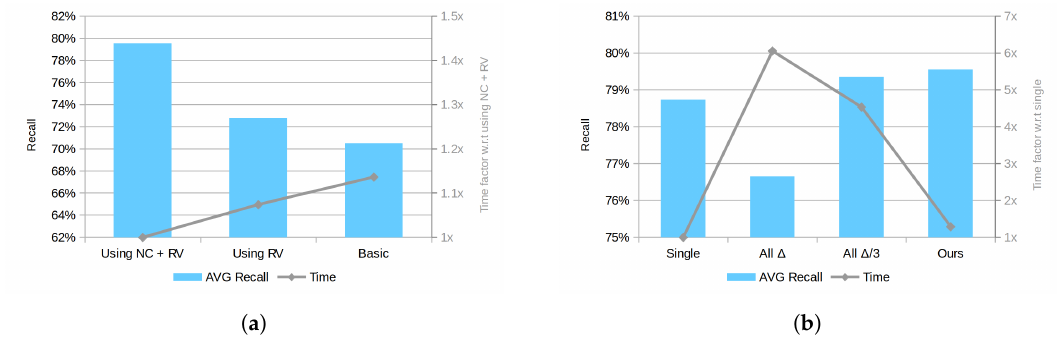
Figure 10. Performance comparison between different approaches. ( a ) comparison of the basic method against RV and NC improvements; ( b ) comparison between matching with single cell, all neighbors ∆ with ∆ and and our method using 16 cells maximum. Note: the left axis shows recall value in 3 percentage and the right axis shows time factor.